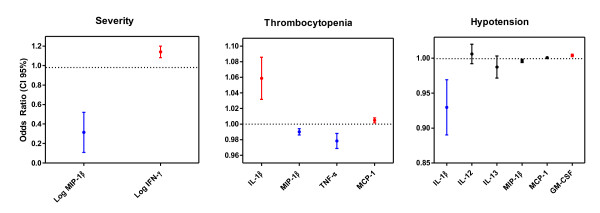
Cytokines detected in plasma as independent factors in predicting severity. Normal GLM model originated from logistic regression analysis using binomial family odds ratios (OD) and 95% confidence intervals (CI). Fifty-nine patients with dengue were grouped according with their clinical manifestations: Severe (N = 39), hypotension (N = 24) or thrombocytopenia (N = 18). Details on Table 2.